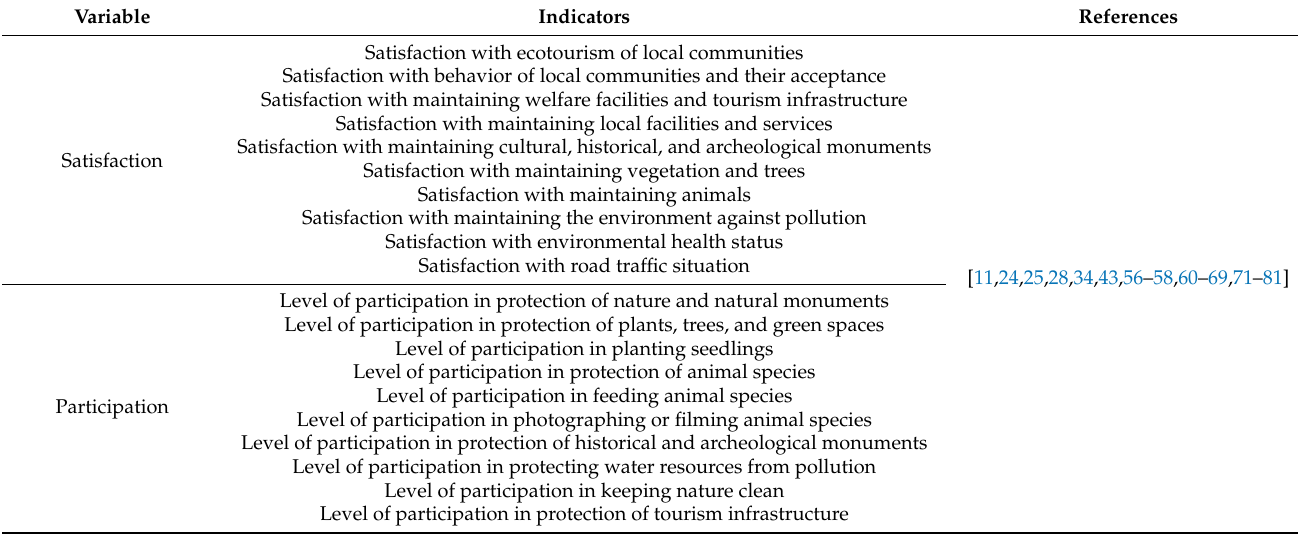
Table 3. Sustainable ecotourism indicators in the demographic–social